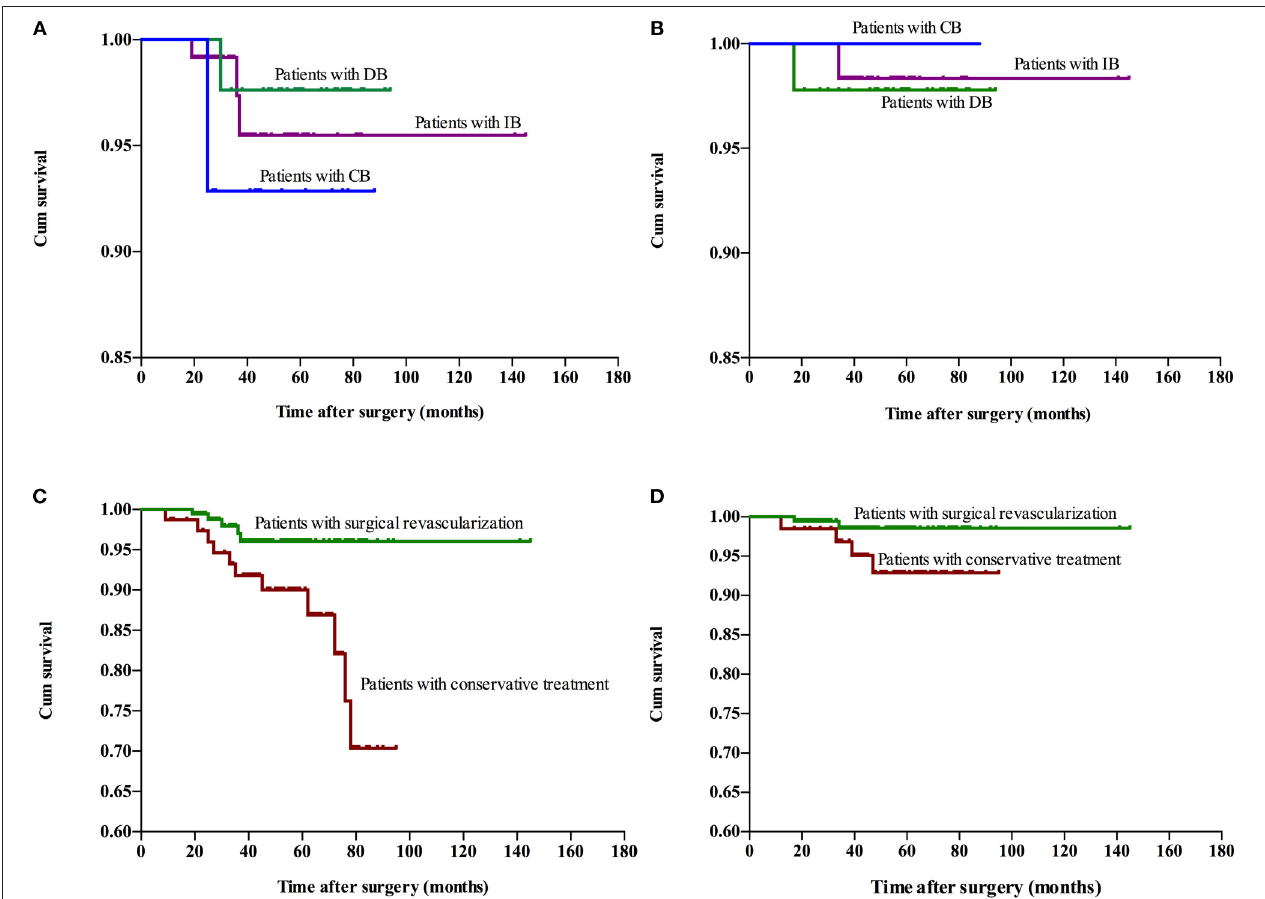
FIGURE 2 | Kaplan-Meier plot for stroke-free survival after surgery. Ischemia-free time (A) and hemorrhage-free time (B) for patients who underwent different surgical modalities. Ischemia-free time (C) and Hemorrhage-free time (D) for patients who underwent surgical treatment and conservative treatment. Cum, cumulative.